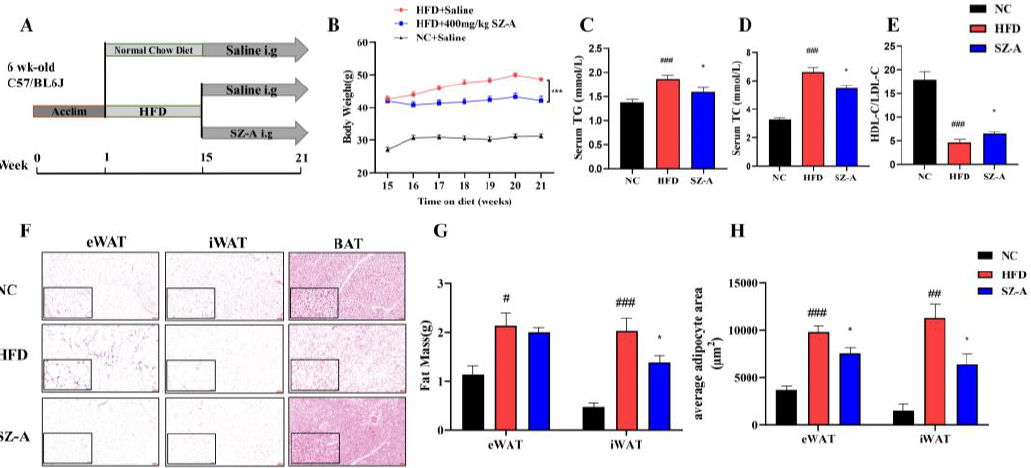
Figure 1. ( A ) Schematic diagram of the experimental procedure ( n = 10/group). ( B ) SZ-A (400 mg/kg i.g.) significantly inhibited HFD-induced weight gain. ( n = 10/group) ( C – E ) Effects of SZ-A (400 mg/kg) on serum levels of TGs ( C ), TC ( D ) and HDL-C/LDL-C ( E ) ( n = 6/group) ( F ) Representative images of hematoxylin-eosin (H&E) staining of eWAT, iWAT, and BAT to observe lipid droplet size. (Scale bar, 100 µ m in red and 50 µ m in blue). ( G ) Total fat mass. ( H ) Quantification of eWAT and iWAT adipocyte area ( n = 3~5/group). Values represent mean ± SEM. (# p < 0.05, ## p < 0.01, ### p < 0.001 HFD vs. NC and * p < 0.05, *** p < 0.001 HFD vs.